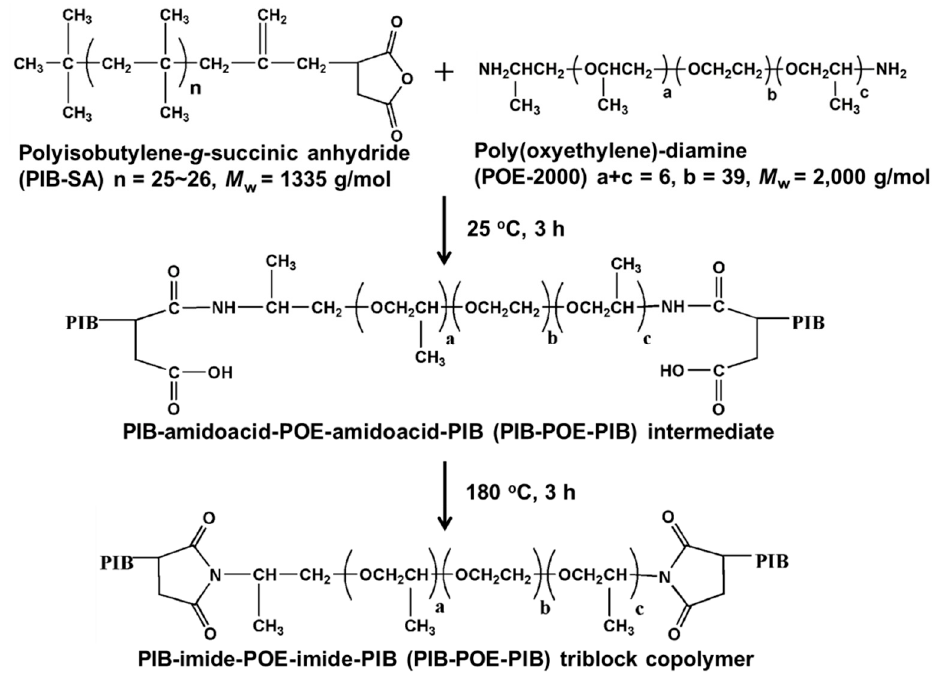
Figure 1. Synthesis of polyisobutylene- b -poly(oxyethylene)- b -polyisobutylene (PIB-POE-PIB) triblock structures (polymeric dispersants) from polyisobutylene- g -succinic anhydride (PIB-SA) and poly(oxyethylene)-diamine (POE-2000) via amidation and then imidation reactions.